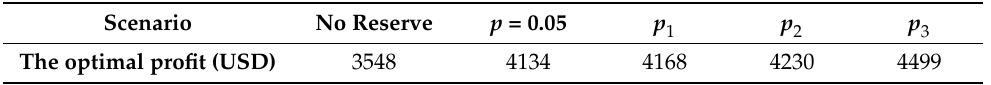
Table 3. The VPP’s optimal